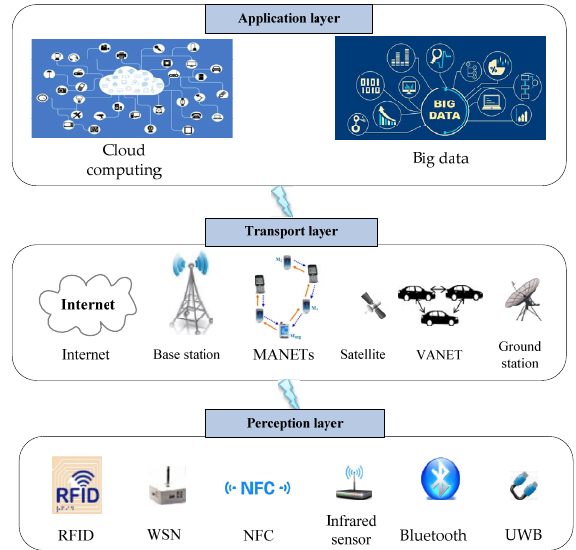
Figure 1. Components of the IoT.